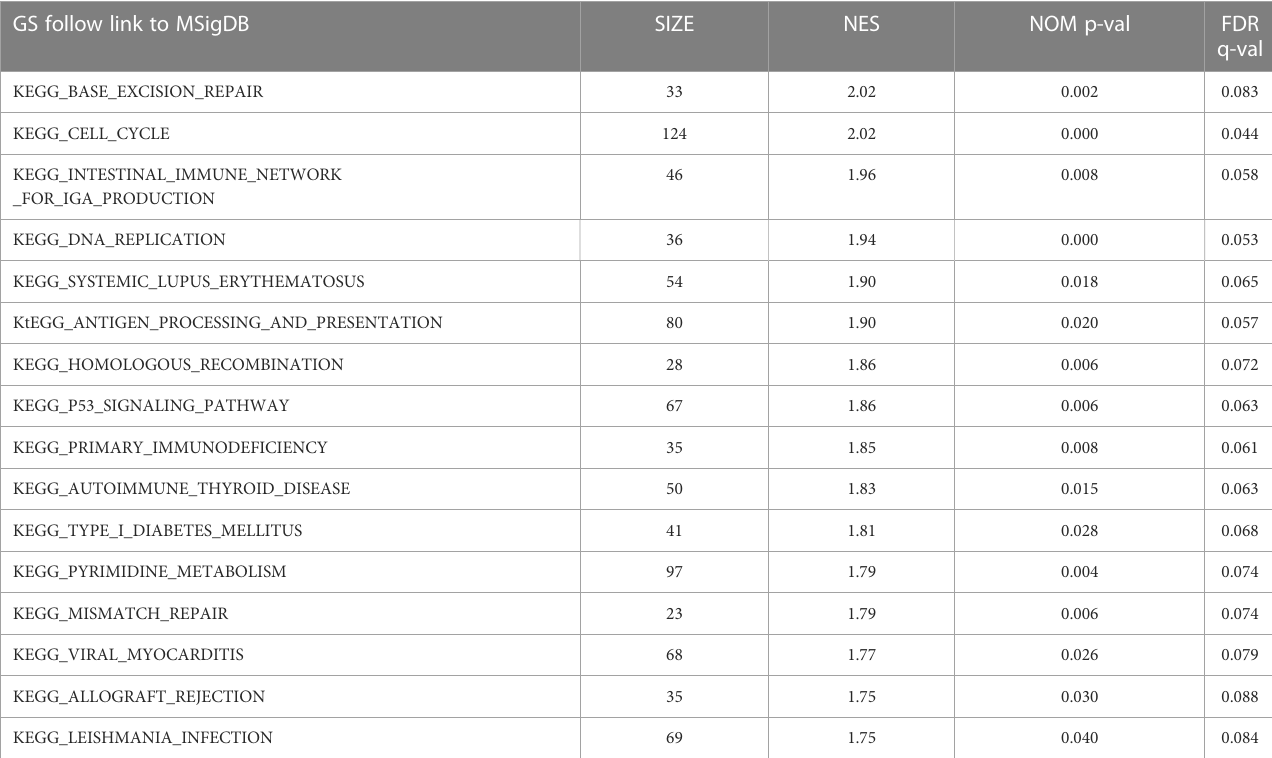
TABLE 3 Gene sets enriched in the high NEIL3 expression